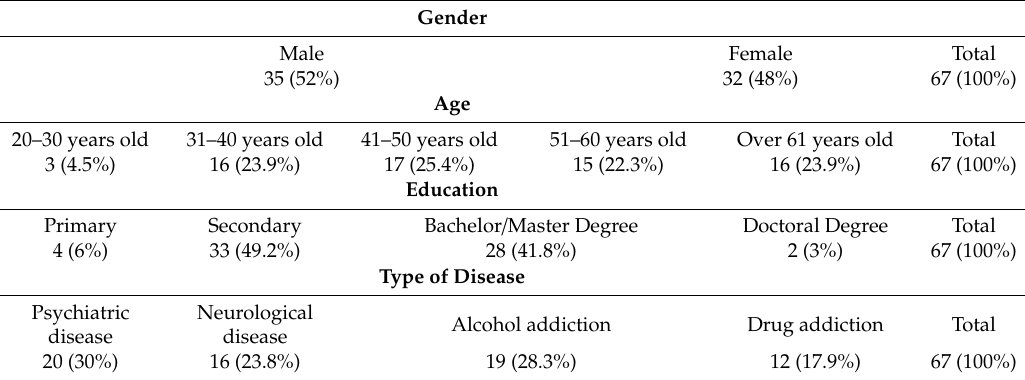
Table 1. Experimental group—gender, age, education and type of disease.